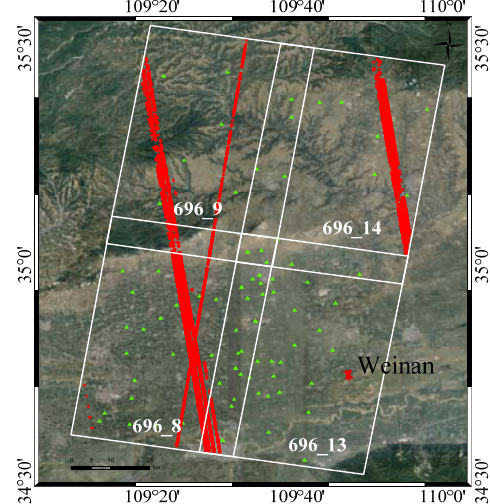
Figure 5. Geographical position and point's distribution of study region, where the green triangles are the GCPs and the red dots are ICESat data.